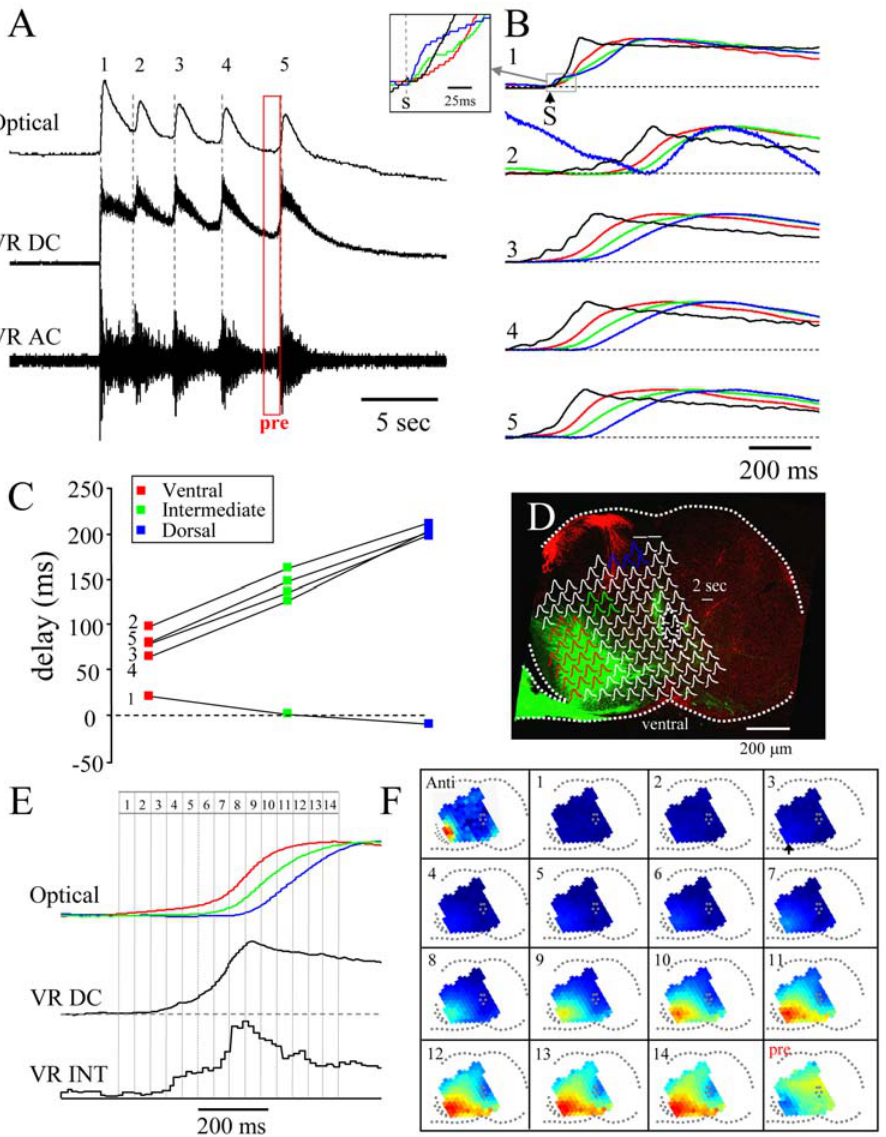
Figure 5. Timing of voltage-sensitive dye signals recorded from different regions of the cord at the onset of individual cycles. A. Electrical and optical recordings from an E10 embryo during an episode initiated by a dorsal root stimulus. The optical recording is from a single diode over the later motor column ipsilateral to the neural recordings. The dotted grey lines demarcate the onset of discharge in each cycle of activity. B. Electrical (black) and optical recordings from 3 different regions of the cord. As in previous figures, the red traces were averaged from diodes over the lateral motor column, the green traces from over the intermediate region and the blue traces from over the dorsal region. The diodes and their locations are shown in panel D. The neurogram is the DC trace low pass filtered between DC-20Hz. The episode was triggered by a single stimulus to the ipsilateral dorsal root at the time marked by the arrow (S). The numbered cycles correspond to those in panel A. The initial part of the first cycle (demarcated by a gray box) has been blown up in the inset to show the timing of the earliest optical and electrical activity. C. Quantification of the timing of optical activity in each cycle with respect to the onset of the electrical activity recorded from the ventral root. The onset delay of the optical signals with respect to the onset of the electrical signal is plotted for each cycle for each of the three regions. The numbers beside the plots correspond to the numbered cycles shown in A and B. Note that the dorsal optical activity precedes that of the electrical activity in the first cycle. Moreover the first cycle exhibits a dorsoventral sequence of activation but all of the other cycles are activated ventrodorsally. D. Location of the diodes whose signals were averaged to produce the traces shown in panels B and E. The diode signals are superimposed over a stained section in which the motoneurons were labeled with DiO and the dorsal root afferents were labeled with DiI. E. Cycle-triggered, averaged DC ventral root potential (VR DC-smoothed with a 20 point moving average) and integrated ventral root discharge (VR INT) together with the optical responses from the three different cord regions ipsilateral to the earliest ventral root activity. The last three cycles (3–5 in A) were averaged for these records. As before, each trace was averaged from several adjacent diodes (shown in D) and was normalized to its peak amplitude. Data were obtained at a sampling interval of 1.011 ms. F. Montage showing the pseudocolored diode array signals superimposed on the outline of the cord slice. Each image is the average of 45 frames obtained at the times indicated by the numbered regions over the traces in E. The first panel in the sequence (Anti) is an image generated during antidromic stimulation of the ventral root to identify the location of the lateral motor column. The arrow in image 3 shows the initial activity within the lateral motor column. The last image in the series (pre) was averaged from the frames delimited by the red rectangle marked pre in panel A. This image shows the spatial distribution of activity just before the last cycle.